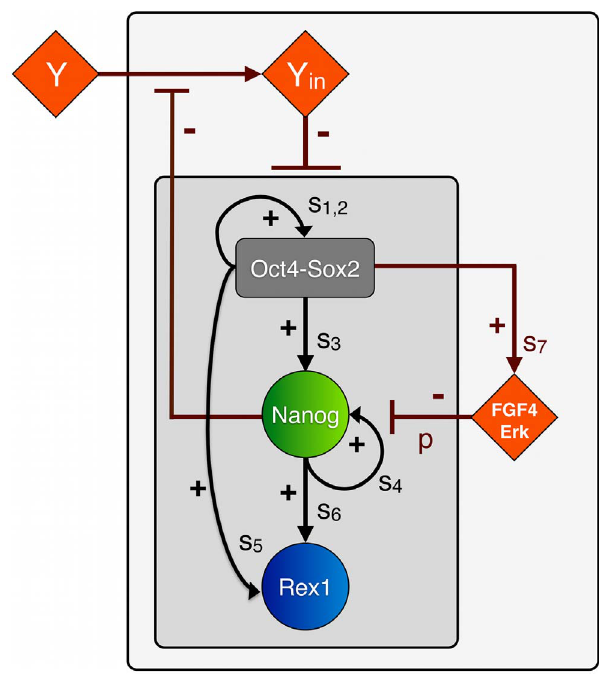
Figure 1. Model scheme of the regulatory network of mESC pluripotency. The core network (inner grey square) is composed of the TFs Oct4-Sox2, Nanog and Rex1, which are linked by positive feedback and feedforward loops (black arrows). The respective transcription rates are denoted by s i . The extended network (outer grey square) includes FGF4/Erk signalling and a differentiation signal Y, the latter facilitating the double-negative feedback loop from Nanog on all factors of the core network. FGF4/Erk is activated by Oct4-Sox2 and represses Nanog with rate p. High Nanog levels block the transmission of differentiation signal Y. The internal part of the differentiation cascade (denoted by Y in ) negatively regulates the expression of Oct4- Sox2, Nanog and Rex1.